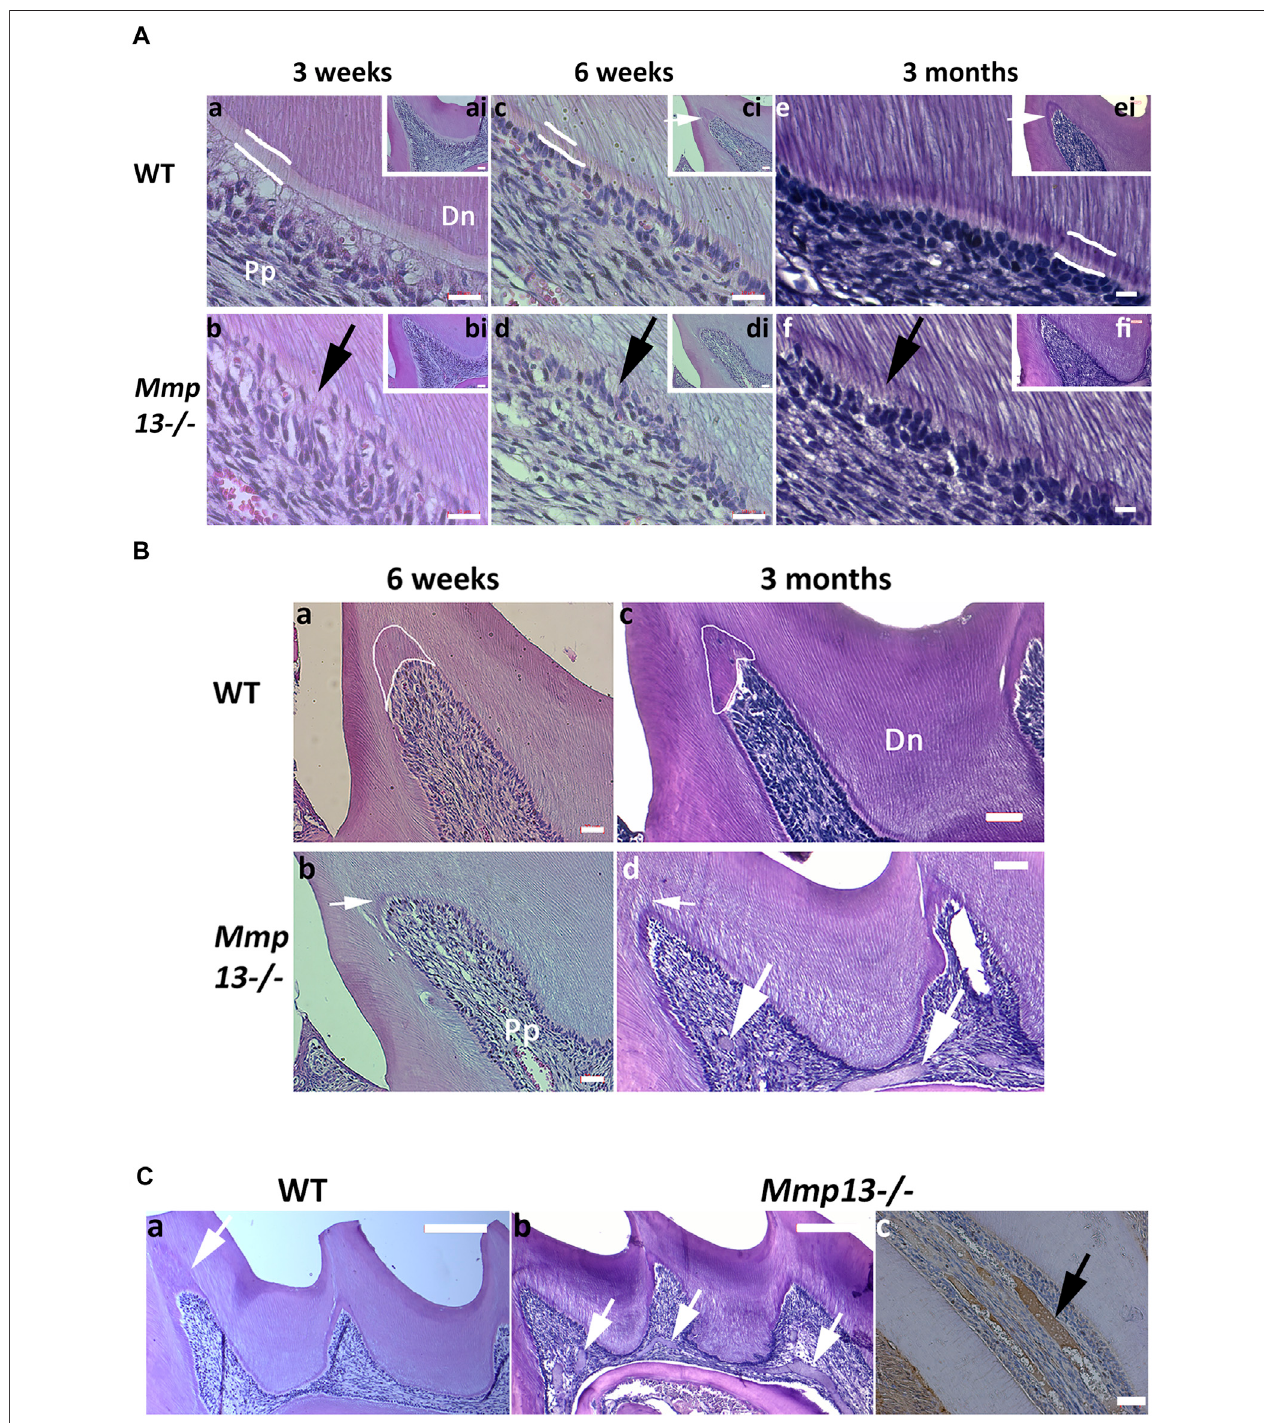
FIGURE 2 | MMP13-ablation alters dentin phenotype, reducing volume and density. (A) Comparative histological analysis of representative sagittal sections of maxillary fi rstmolarsfrom Mmp13 − / − andWTmiceatpostnatal3-week,6-week,and3-months. (a – f) H&Estainingdemonstratesthealtereddentinstructure.Analysisof WT (a, c, e) and Mmp13 − / − (b, d, f) mouse molars at 3-week, 6-week, and 3-month highlights progressively altered the dental phenotype including alterations in dentin tubule regularity, disruption of odontoblast layer organization and palisade ( d – h . black arrow), narrowing of the predentin layer (indicated sketched white lines in a, c,e ),andreducedreactionarydentinformation( ci,ei .[inset]smallwhitearrows). a – f representhighermagni fi cationofdistalcusp(inset; ai – fi ).Scalebars= (ai – fi ) 20 μ m (originalmag.×20); (a – f) 10 μ m(originalmag.x63). (B) Reactionarydentinogenesiswasanalyzedin6-weekand3-monthmaxillary fi rstmolarteethofWTand Mmp13 − / − mice using H&E staining of sagittal sections. Reactionary dentin is reduced after MMP13-ablation ( Bb, Bd — white arrows) compared with WT ( Ba, Bc — white encircled